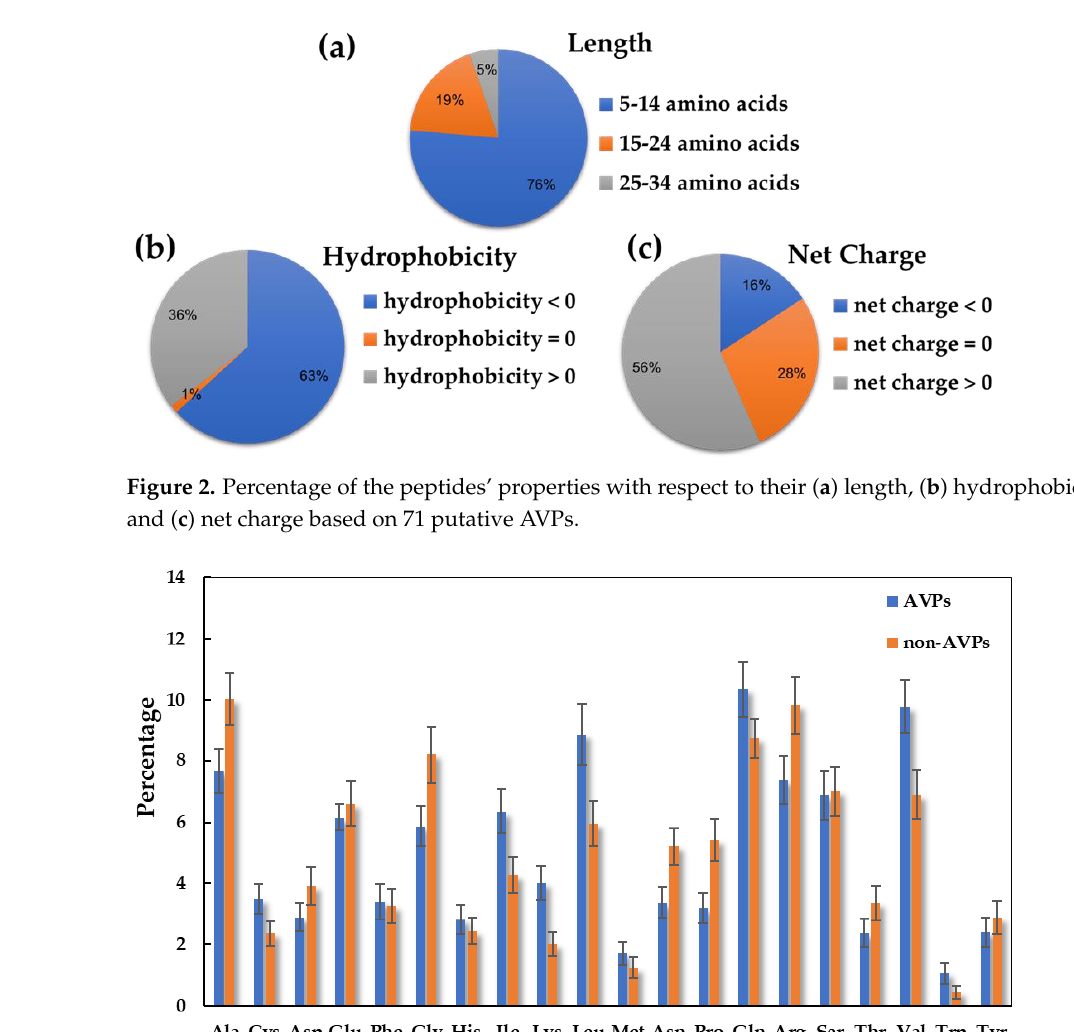
Figure 3. Compositional analysis represents the preferences between the significant AVPs and non-AVPs.